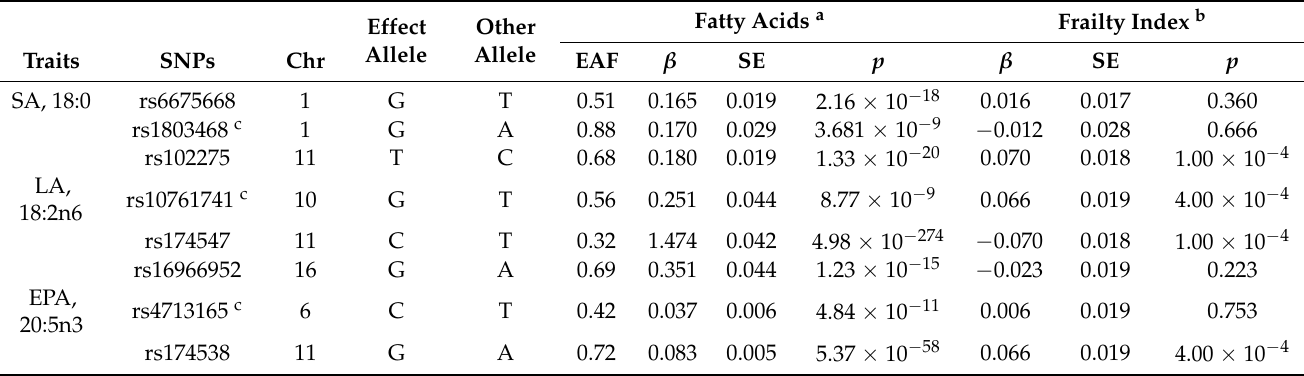
Table 2. Summary statistics for sensitivity analysis using proxy SNPs to consider the possibility of palindromic SNPs in three traits of fatty